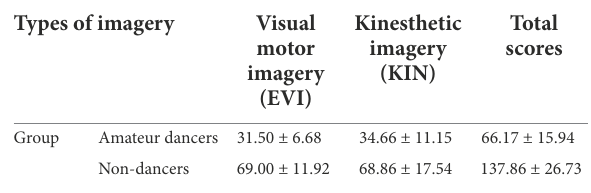
TABLE 2 Mean VMIQ scores (M ±